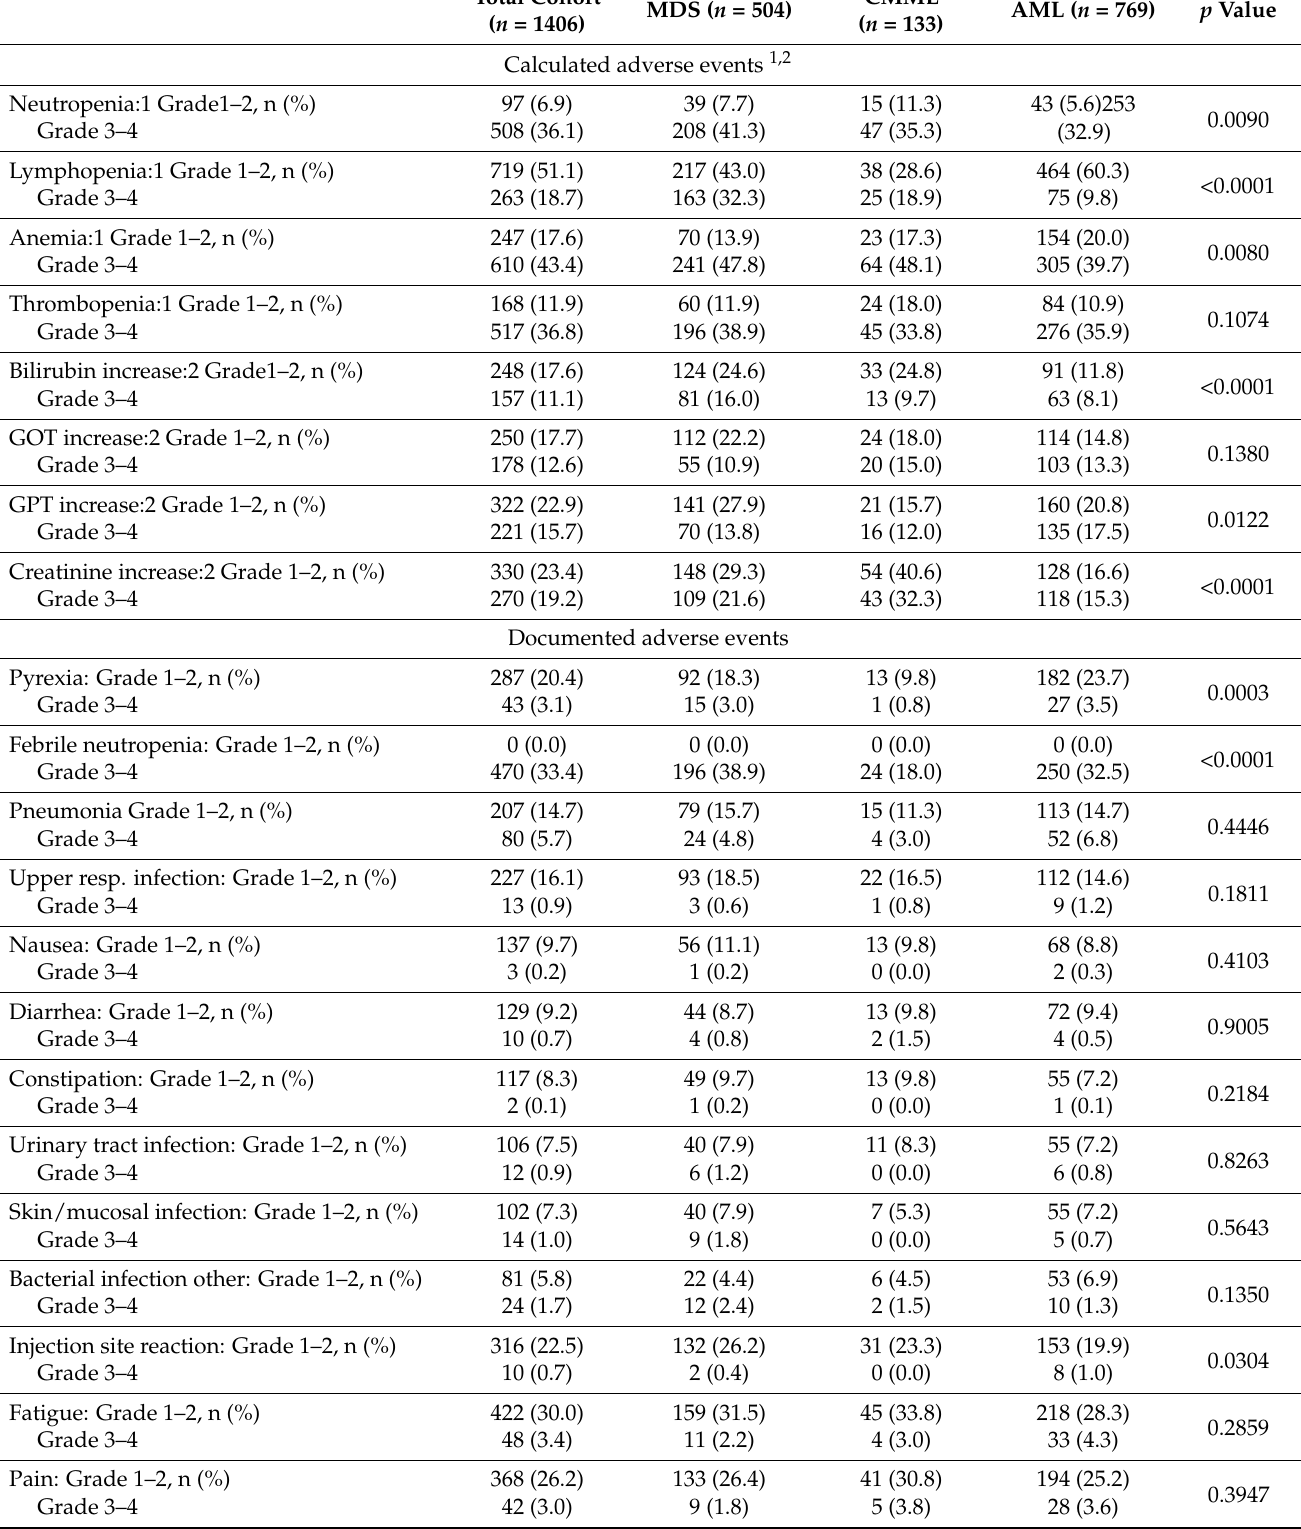
Table 2. Adverse events of patients included in the Austrian Registry of Hypomethylating